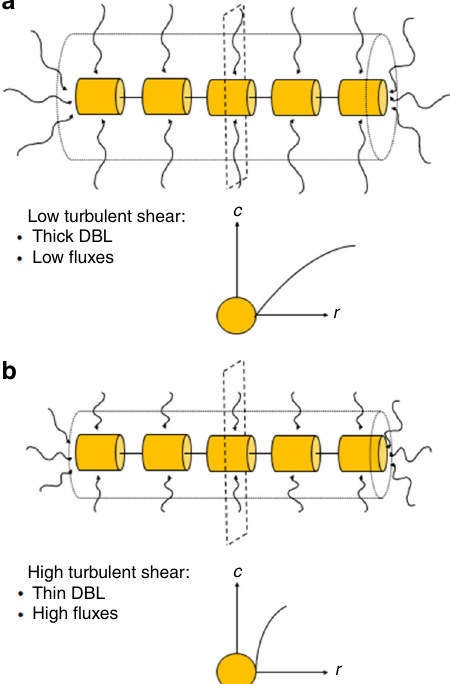
Fig. 1 Diffusive boundary layers (DBL) surrounding chain-forming diatoms. The radial diffusion-limited concentration gradient across the DBL from the ambient water to cell surface for the middle cell under low turbulent shear ( a ) and under high turbulent shear ( b